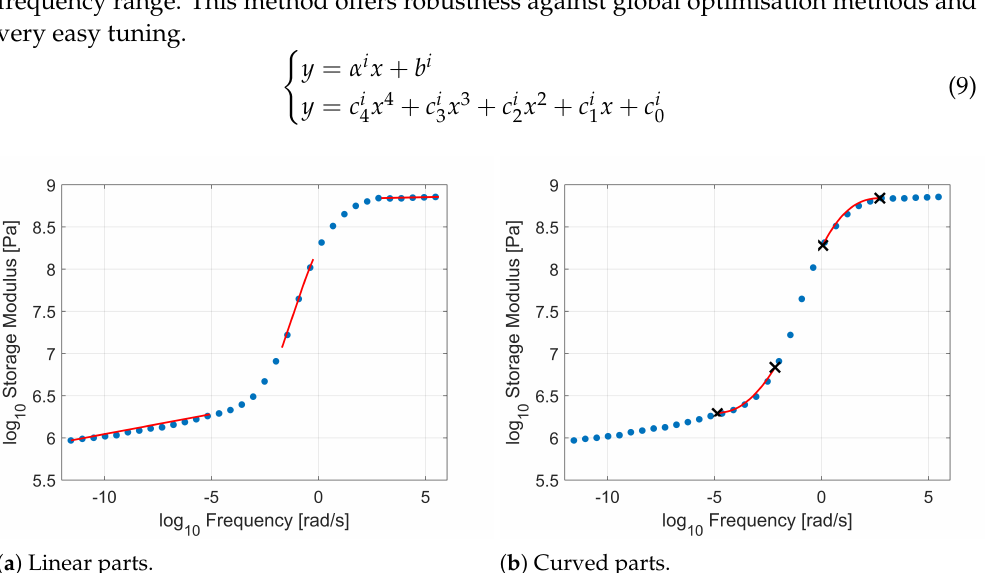
Figure 4. Demonstration of linear ( left ) and higher degree ( right ) polynomials with the critical boundary points that initiate curvature, for the storage modulus of SBR with no phr carbon black